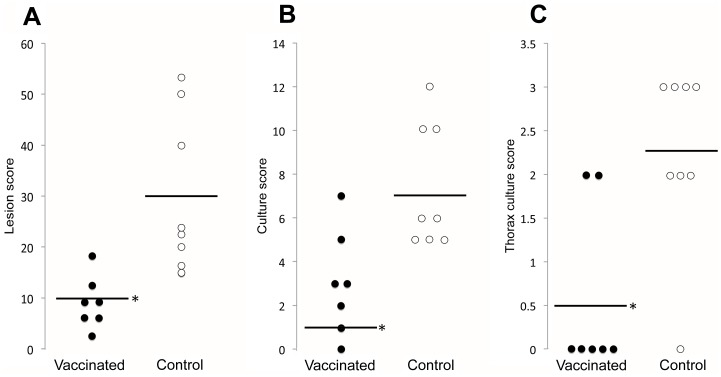
Oral vaccination with IV protects wild boar against mycobacterial infection.(A) Lesion score, (B) culture score and (C) thorax culture score in vaccinated (N = 7) and control (N = 8) wild boar. Solid lines show the median values. Values were compared between groups by Student’s t-test with unequal variance (*P≤0.005).